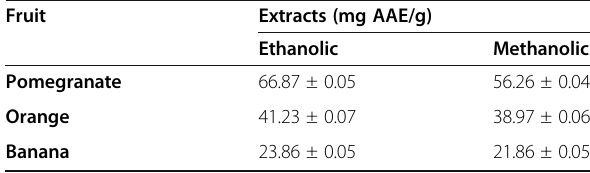
Table 4 Total antioxidant capacity of the used fruit peel extracts